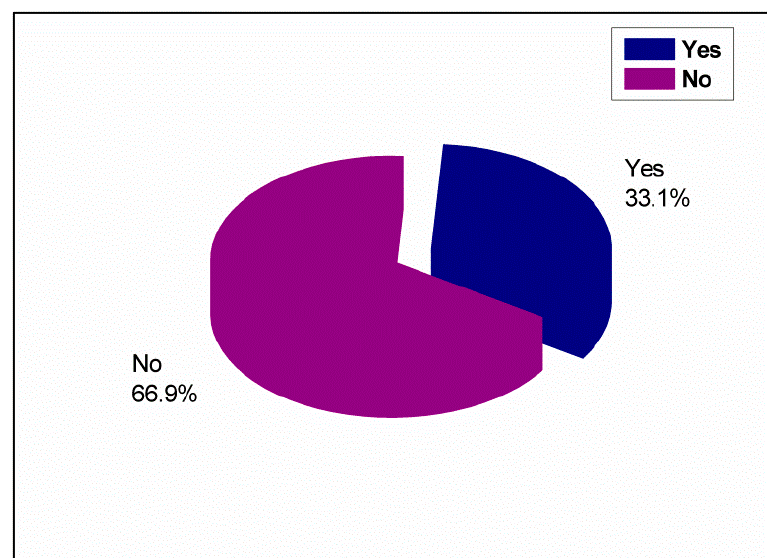
Figure 3. Reasons for visiting a dentist.